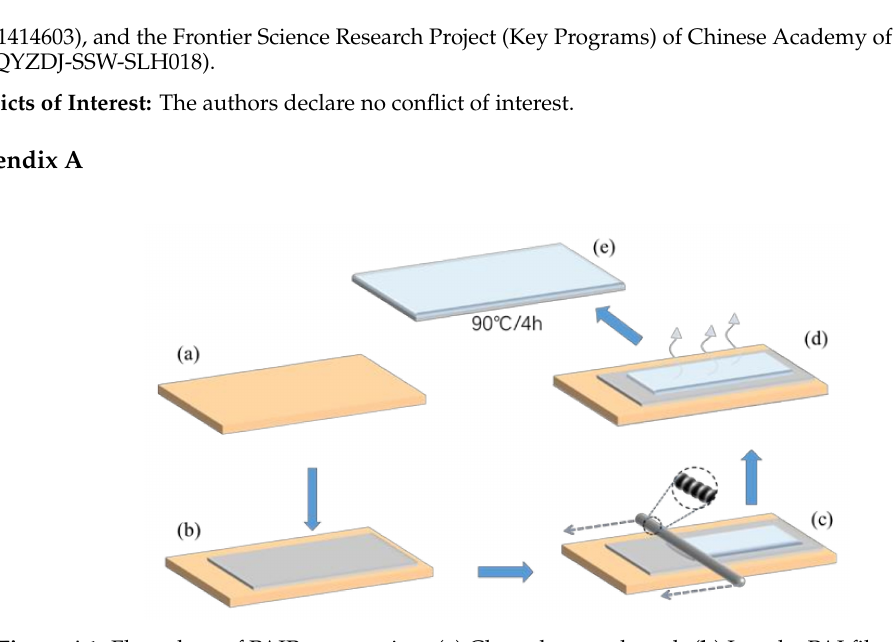
Figure A1. Flow chart of PAIP preparation. ( a ) Clean the crap-board. ( b ) Lay the PAI film flat on the surface of the crap-board. ( c ) Scraping PDMS solution onto PAI. ( d ) Remove the solvent of PDMS. ( e ) Curing the PDMS.